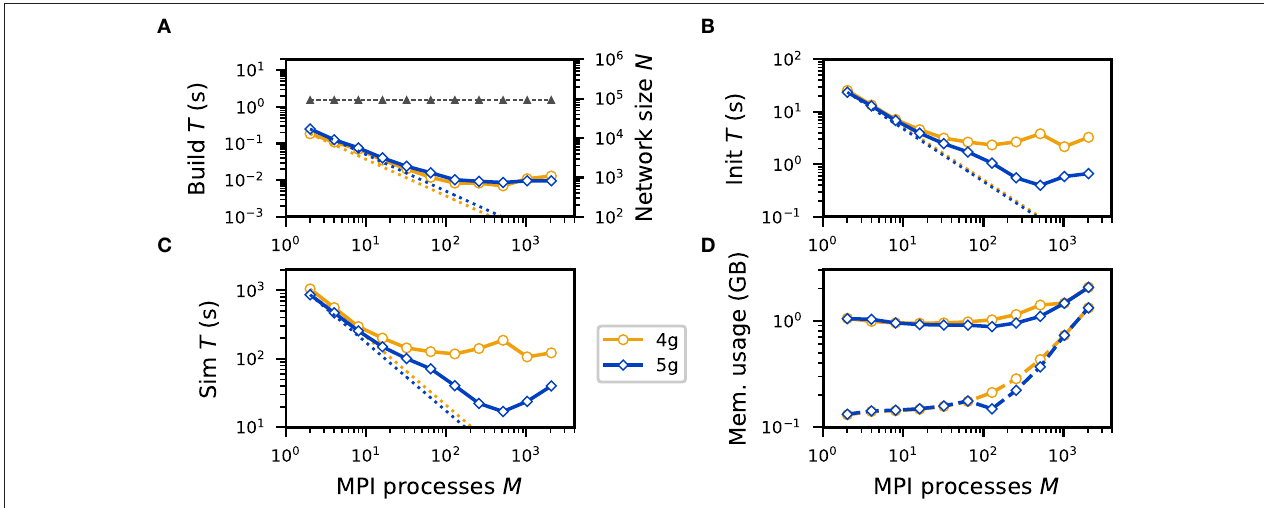
FIGURE 6 | Strong scaling of neuronal network simulation with gap junctions on a petascale computer. Runtime and memory usage per compute node for an increasing number of MPI processes in logarithmic representation M ∈ { 2 ; 4 ; 8 ; 16 ; 32 ; 64 ; 128 ; 256 ; 512 ; 1024 ; 2048 ; 3328 } with two MPI processes per compute node and T = 12 threads per MPI process on JURECA. N = 94,720 neurons with K = 60 gap junctions per neuron. Network dynamics simulated for 0.5 s of biological time. Color code and marker styles as in Figure 5 ; logarithmic vertical axes. For reference, straight dotted lines indicate perfect scaling. (A) Build time (logarithmic). Gray triangles and dashed line show the total network size N (right vertical axis, logarithmic). (B) Init time. (C) Sim time (logarithmic). (D) Cumulative memory usage for a single MPI process after NEST startup (dashed curves) and after simulation (solid